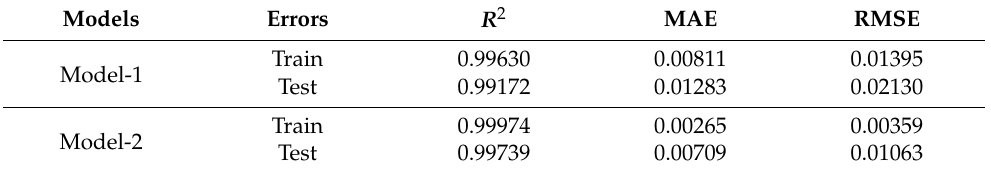
Table 3. Train and test errors.